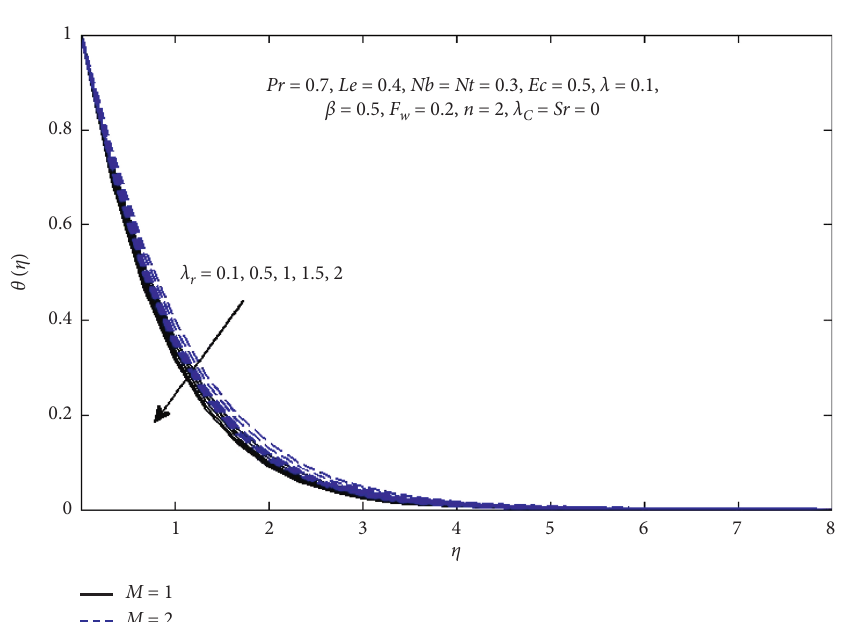
Figure 6: Variation of temperature θ concerning η with various values of λ